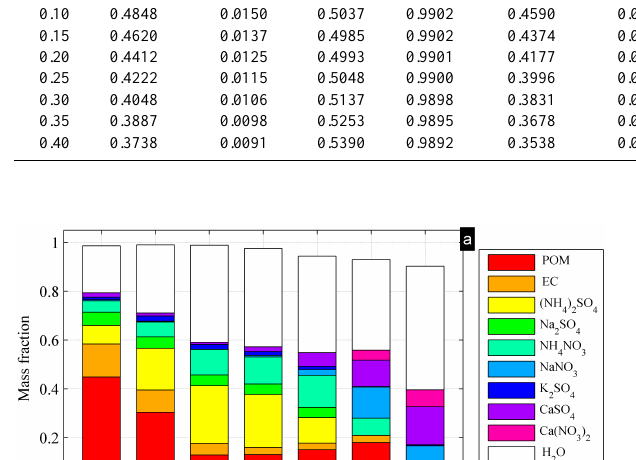
Table 5. Statistics of f sp (RH) curve fitting by Eq. (9) with constant parameter “b”. “b” f sp , int f sp , ext f sp , cs average “a” Standard average average average “a" Standard average average average “a” Standard average average deviation “a” residual correlation deviation “a” residual correlation deviation “a” residual correlation coefficient coefficient coefficient − 0.10